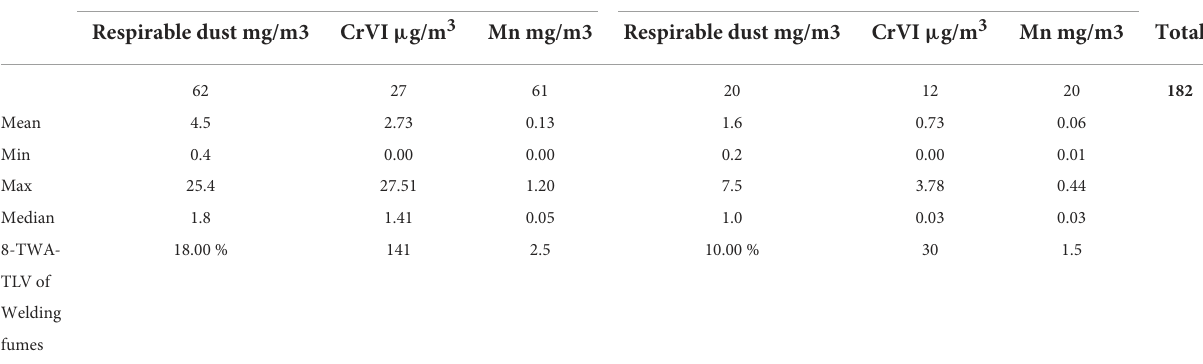
TABLE 2 Results of welding fume exposure assessment.